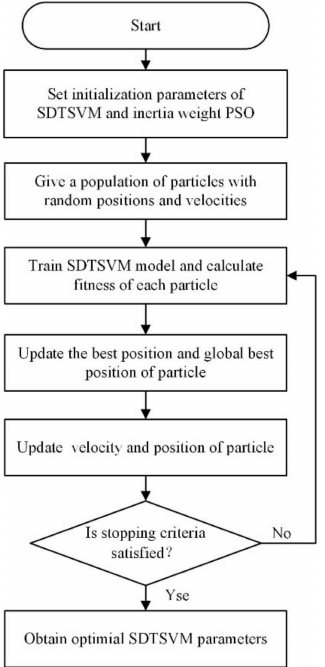
Figure 5. The SVM parameter optimization process using an inertia weight Particle Swarm Optimization (PSO) algorithm.